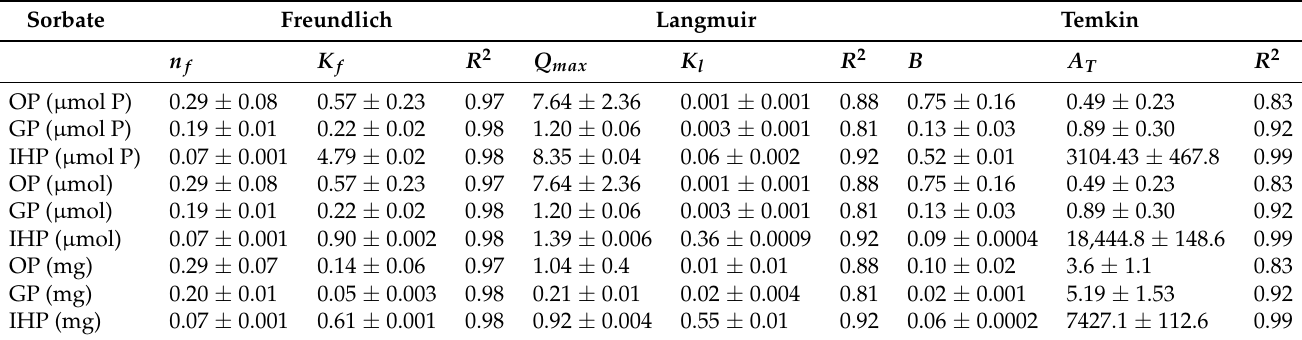
Figure 2. Adsorption isotherms of OP, GP, and IHP on goethite at 0.01 M CaCl 2 electrolyte solution (pH 5). Points represent the original data and dashed lines represent the fitted isotherms according to Freundlich model. Table 1. Freundlich, Langmuir and Temkin isotherm coefficients ( K f , n f , K l , A T and B T ) of OP, GP and IHP adsorption on goethite at pH 5 in 0.01 M CaCl 2